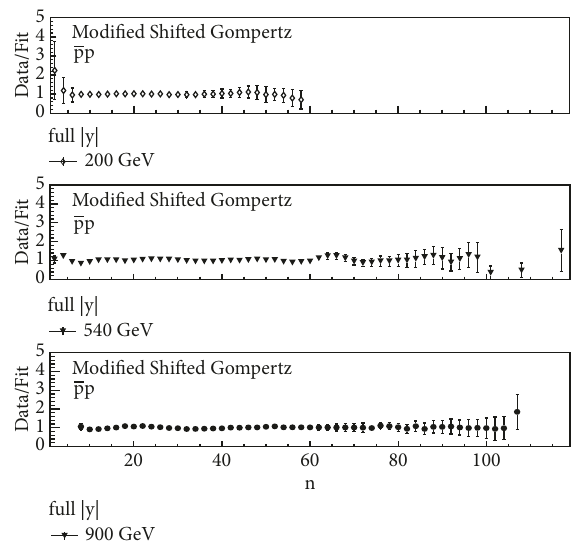
Figure 6: Ratio plots of data versus modified shifted Gompertz fit values for 𝑝𝑝 collisions in full phase space.